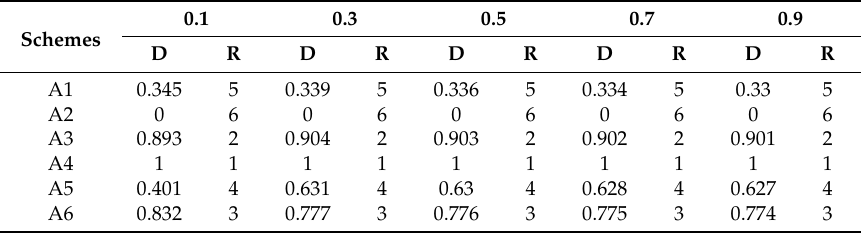
Table 11. Schemes with different contracted revenue ratio ranking results.